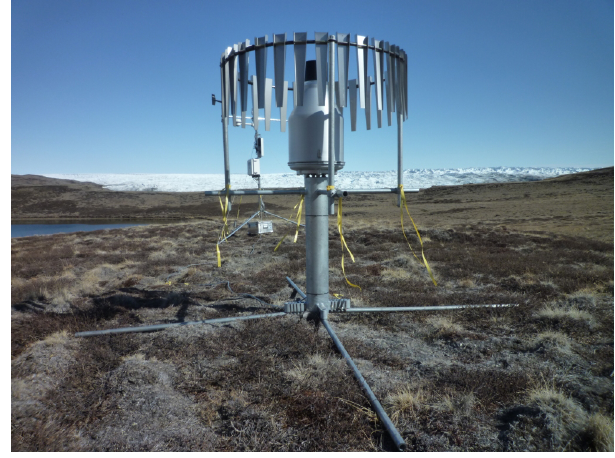
Figure 2. The automatic weather station (AWS) installed in April